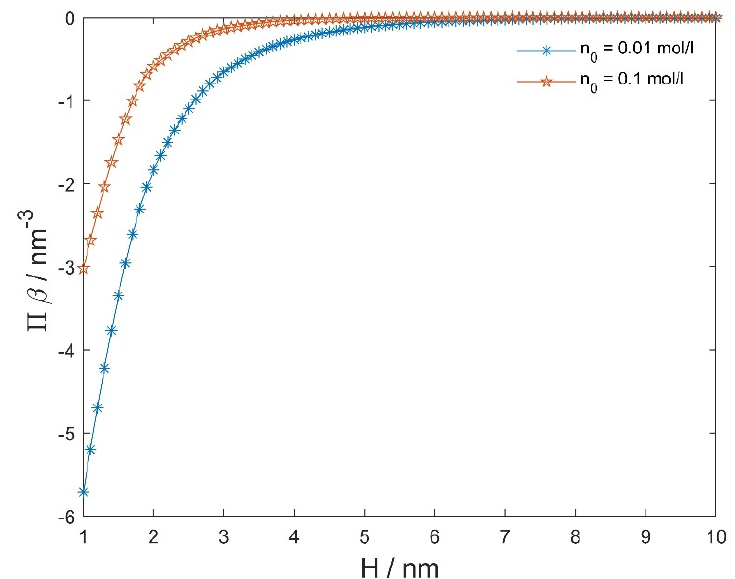
Figure 8. The calculated osmotic pressure between negatively and positively charged flat surfaces as a function of the distance between the two surfaces (H) (see Figure 7), calculated within the modified LPB model (Equations (1) and (2)) for two values of the bulk salt concentration. Other model parameters are: 𝜎 (cid:2869) = 0.2 As/m 2 , 𝜎 (cid:2870) = −𝜎 (cid:2869) , 𝑇 = 298 K, concentration of water 𝑛 (cid:3050) /𝑁 (cid:3002) = 55 mol/L, and dipole moment of water 𝑝 (cid:2868) = 3.1 Debye, where 𝑁 (cid:3002) is the Avogadro number.